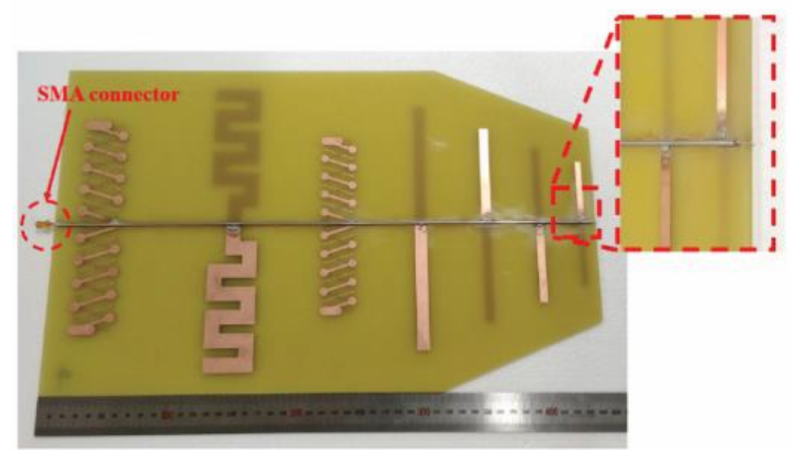
Figure 9. PLPDA design with two folded-planar helix dipoles [46].